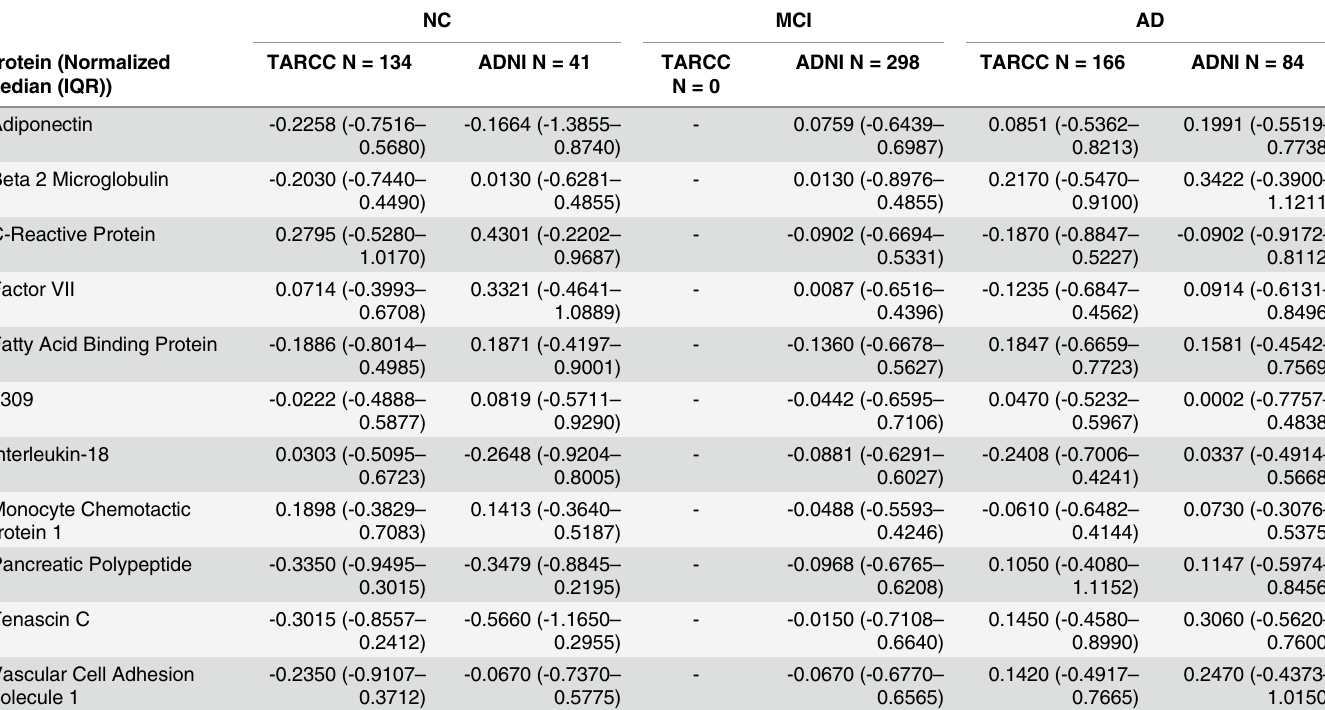
Table 2. Serum protein